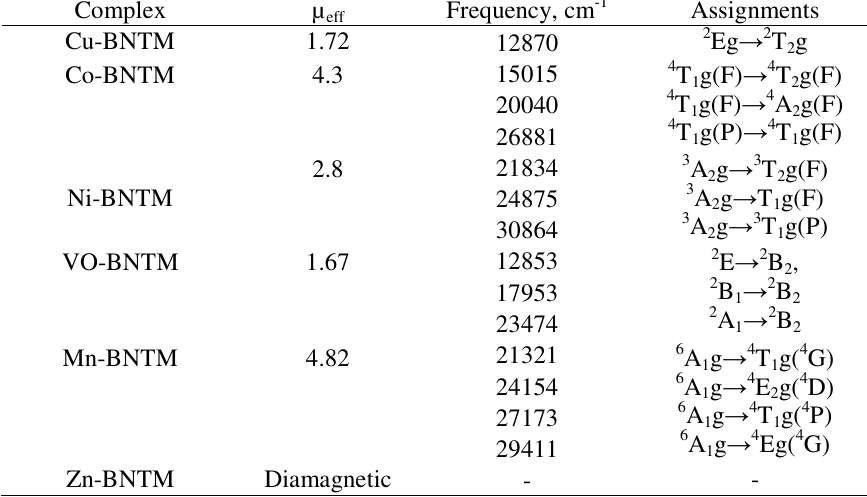
Table 3 . Electronic spectral data and magnetic moment data Complex µ Frequency, cm -1 eff